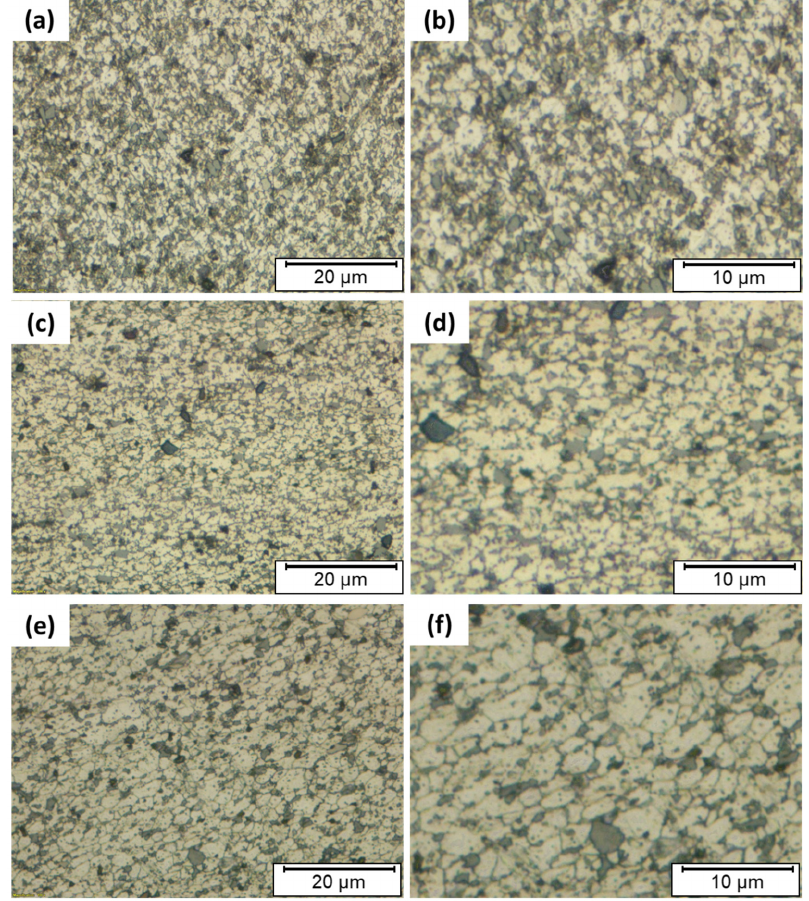
Figure 10. Micrographs of AMPs produced at a constant rotation speed of 1200 rpm and different feeding speeds of ( a ) 3 mm/min, ( c ) 4 mm/min, ( e ) 5 mm/min. Figures ( b , d , f ) are the higher magnifications of ( a , c , e ), respectively.